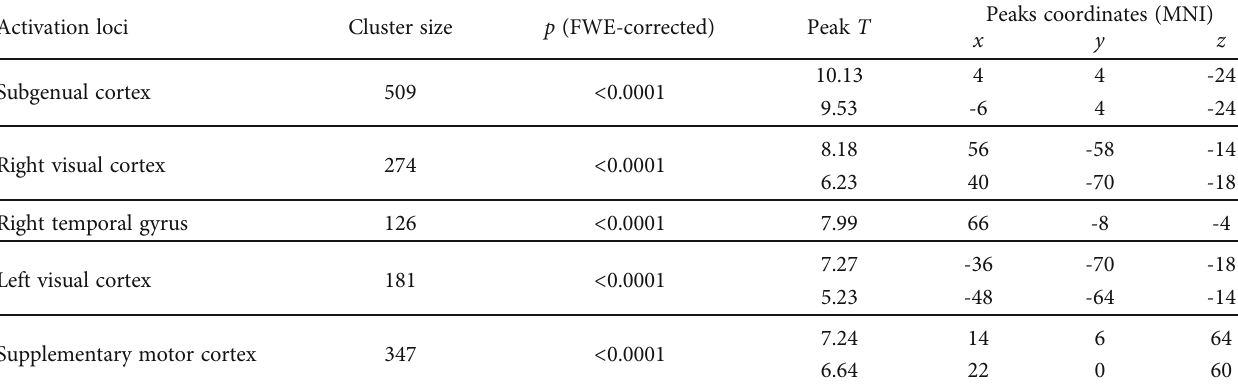
Table 2: MNI coordinates for the main regions showing the increased BOLD signal in the on > off contrast at whole brain level. Activation loci Cluster size